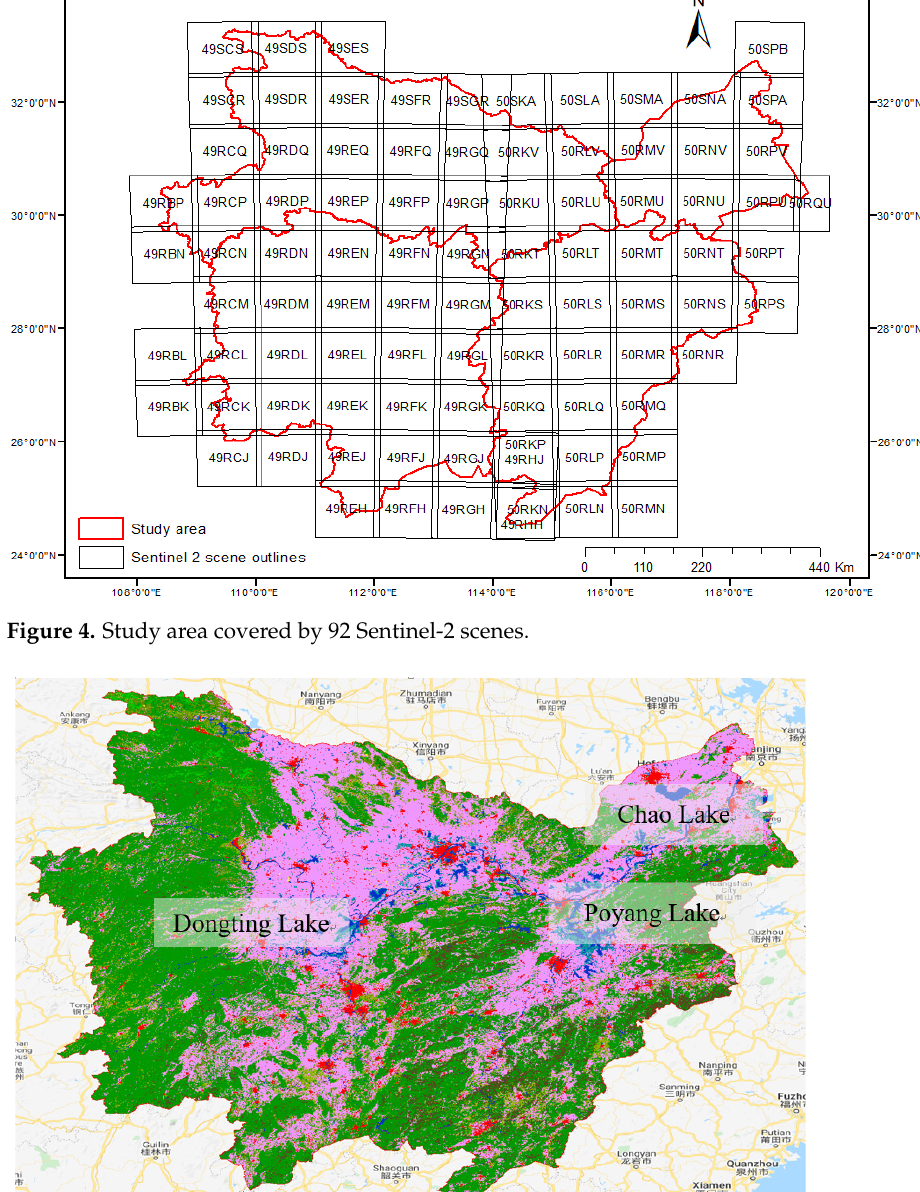
Figure 6. Workflow chart. 2.3.1. LULC Map Extracted from Multi-Source Data The application of machine-learning algorithms on RS imagery for LULC mapping has attracted considerable attention [38]. The algorithms have been divided into super- vised and unsupervised techniques [39]. In our research, accurately quantifying surface